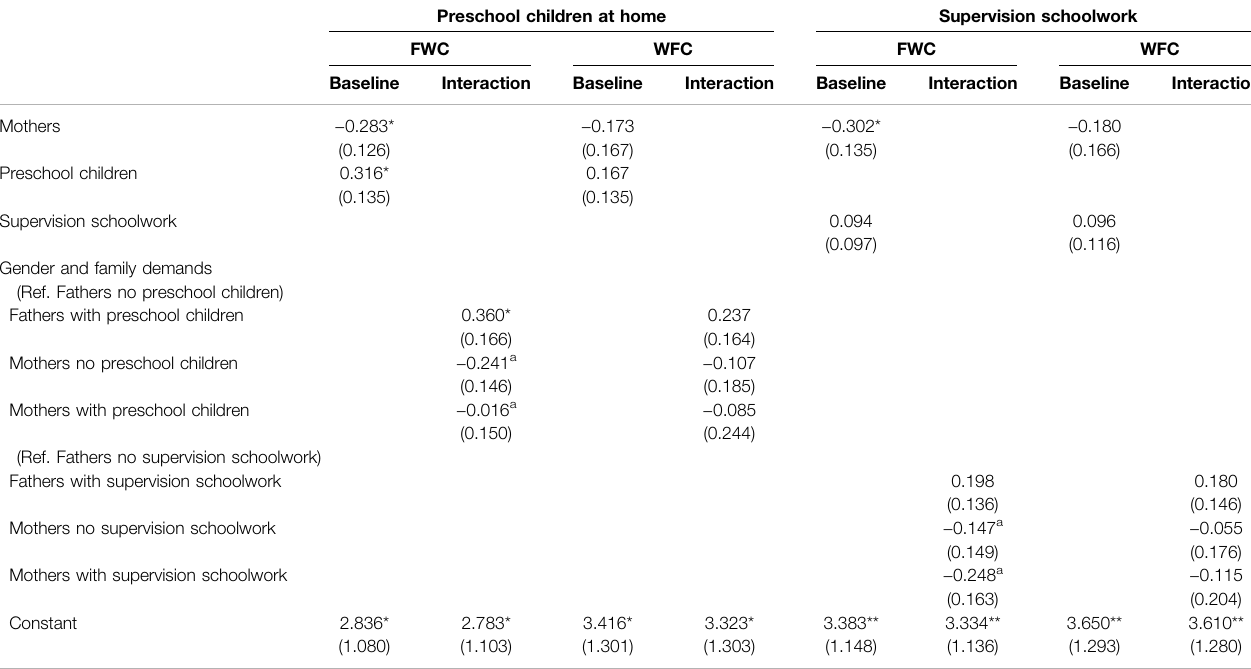
TABLE 6 | Linear regressions on fathers ’ and mothers ’ FWC and WFC accounting for family demands ( N (cid:1) 227).